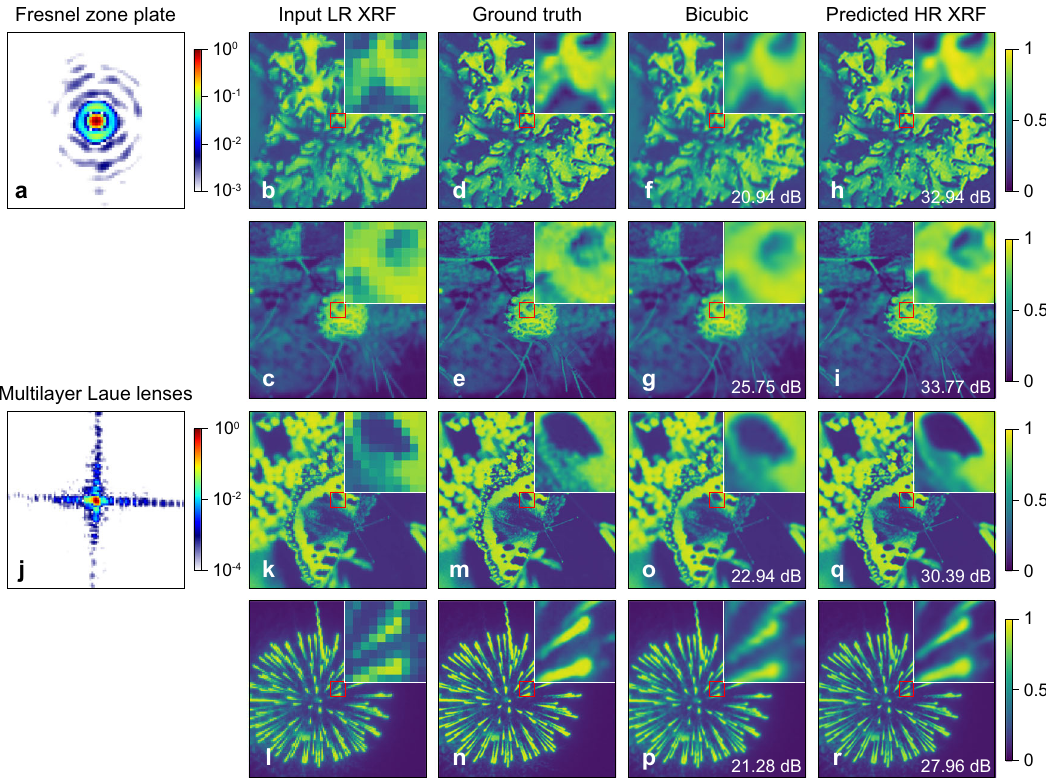
Fig. 3 The representative results for the performance of the RDN model in testing with different X-ray nanoprobes. a X-ray probe from an FZP. b , c Corresponding input testing LR XRF patterns from the FZP. d , e The ground truth. f , g The corresponding bicubic interpolation. h , i The predicted HR images from the RDN model. j X-ray probe from MLLs. k , l Corresponding input testing LR XRF patterns from the MLLs. m , n The ground truth. o , p The corresponding bicubic interpolation. q , r The predicted HR images from the RDN model. Here, the insets show the center marked by the red vary a lot from sample to sample. However, the relation between RDN model. As shown in Fig. 3a, g the two different X-ray beam the measured LR XRF images and the measured materials can wavefronts are obtained via the ptychographic reconstructions always be described by Eq. 1. To increase the diversity of the from an FZP and MLLs at HXN, respectively (see Methods for training dataset and the generality of the model, we use the details). The composition and structure of real-world materials can